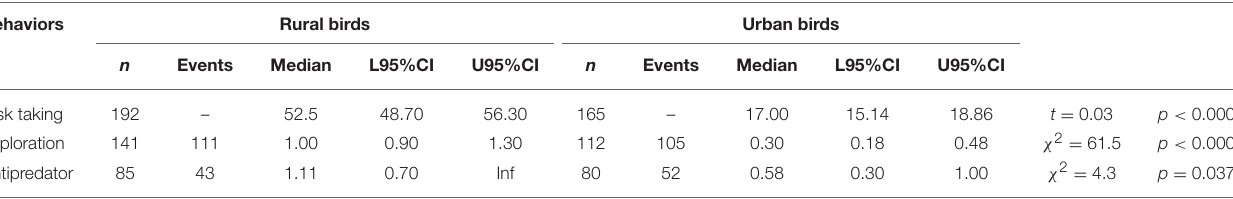
TABLE 1 | Median log-transformed values (and 95% credible intervals: L95%CI: lower tail, U95%CI: upper tail) obtained for risk taking (measured as FID, in m), exploration (measured as latency in approaching a new food source, in minutes) and aggression toward predators (measured as latency in approaching a predator, in minutes) in rural and urban burrowing owls Athene cunicularia . Behaviors